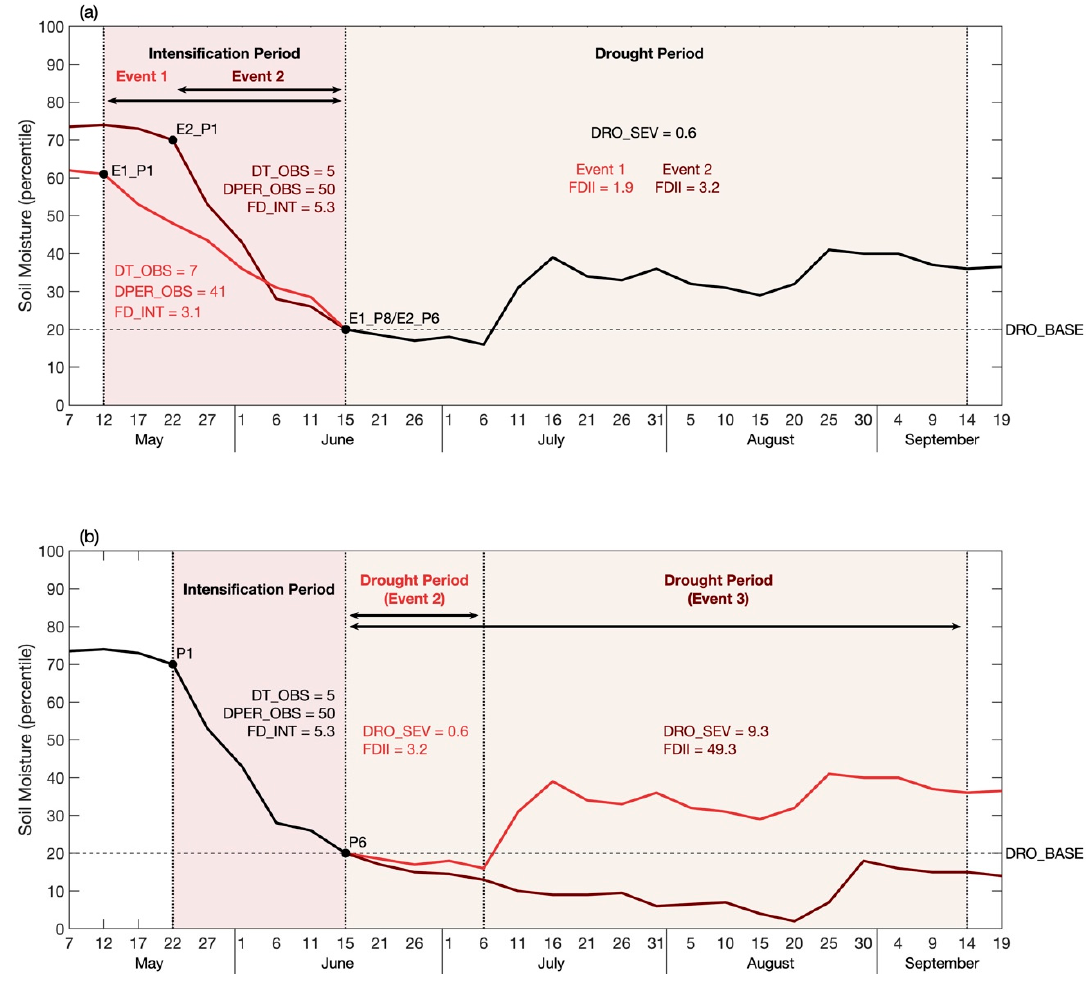
Figure 1. Examples illustrating how differences in the ( a ) rate of intensification (FD_INT) and ( b ) drought severity (DRO_SEV) for three hypothetical flash drought events modulate the magnitude of the FDII.